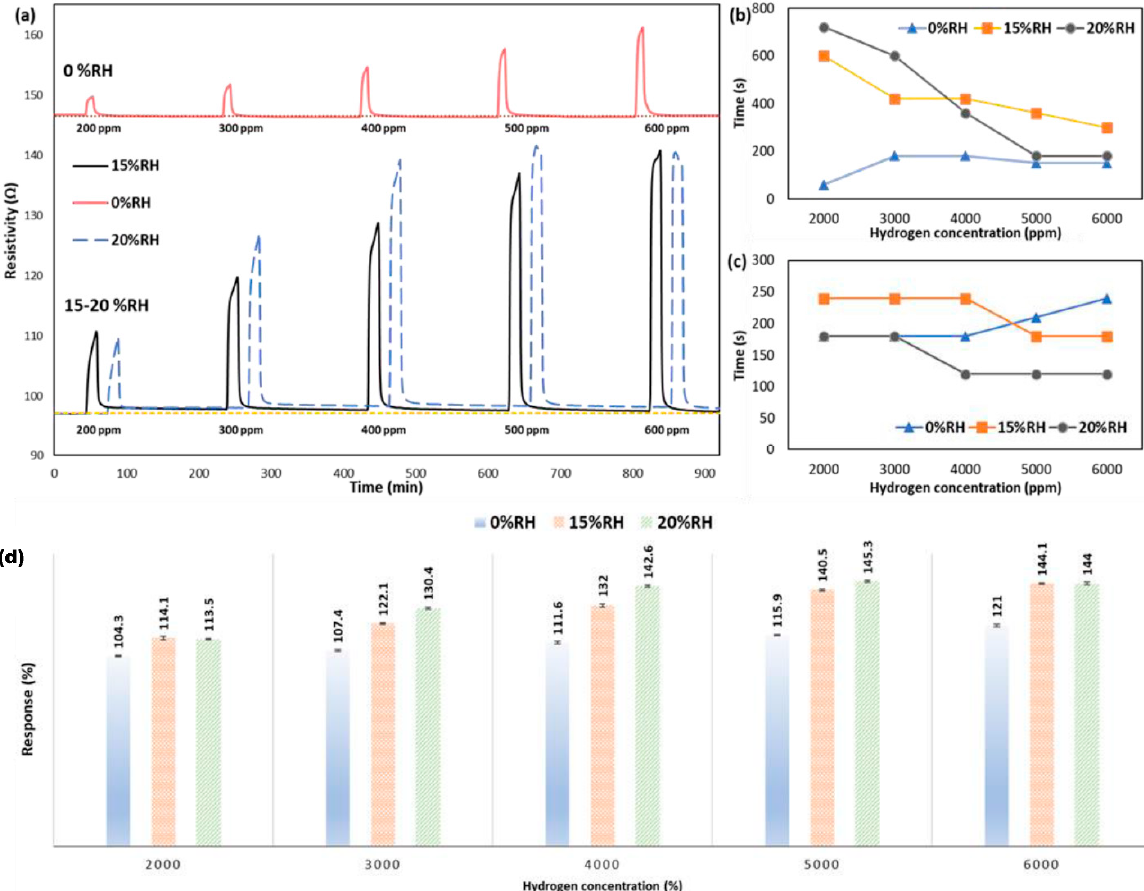
Figure 10. ( a ) Dynamic response of Dy 2 O 3 -Pd-PDA/rGO sensor towards H 2 with different concentrations (2000–6000 ppm) at 150 °C, and relative humidity levels (0 %RH, 15 %RH, and 20 %RH) under UV radiation; ( b ) response time and ( c ) recovery time of the sensor at 0 %RH, 15 %RH, and 20 %RH as a function of H 2 concentrations. ( d ) Response magnitude of the sensor towards H 2 with different concentrations at 0 %RH, 15 %RH, and 20 %RH.